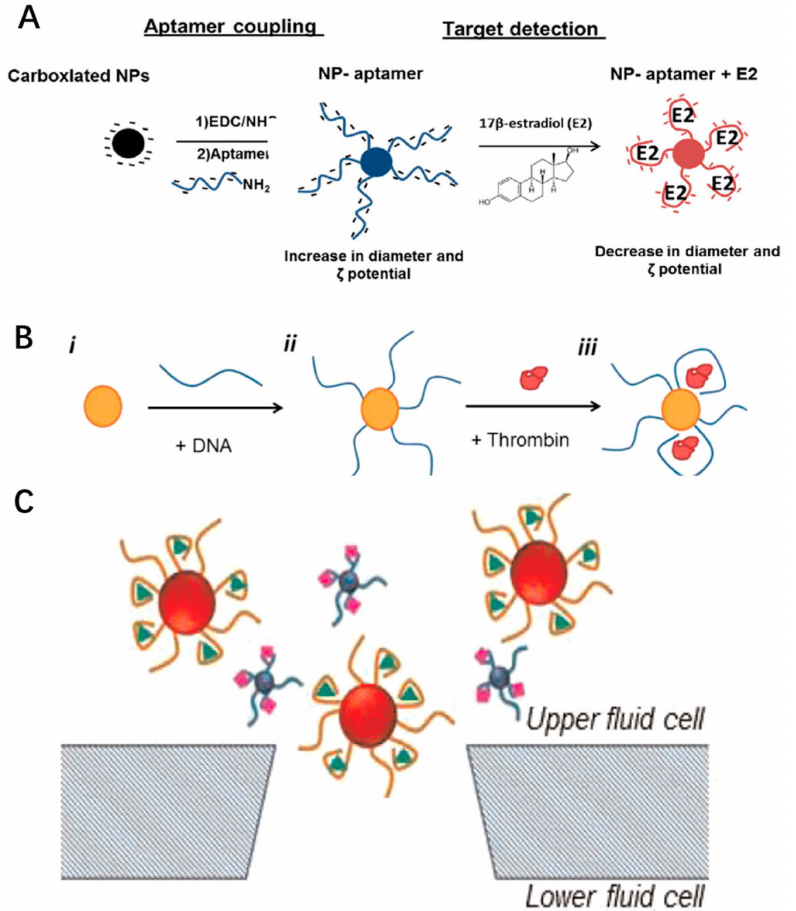
Figure 10. RPS—aptasensors based on aptamer folding for biomolecule detection. ( A ) Aptamer- based sensor for 17 β -estradiol detection via the size contraction response of aptamer-functionalized nanoparticles, reproduced with permission from [104]. Copyright 2014 Biosensors and Bioelectronics. ( B ) AptaTRPS based on aptamer-tagged nanoparticles to monitor the interaction between the aptamer and protein, reproduced with permission from [105]. i , ii , iii represent bare NPs, NPs modified by aptamers, and modified NPs interacted with targets respectively. Copyright 2014 American Chemistry Society. ( C ) Size-multiplexed detection of biomolecules using aptamers and TRPS, reproduced with permission from [106]. Copyright 2015 Biosensors and